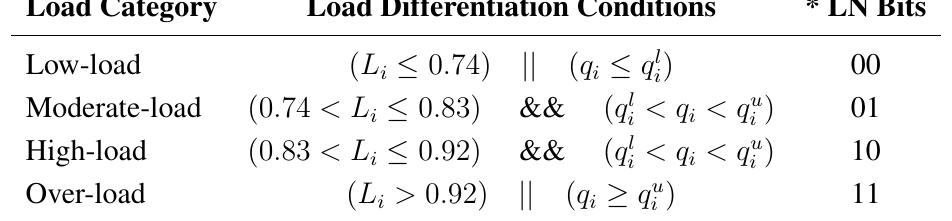
Table 1. Load-status